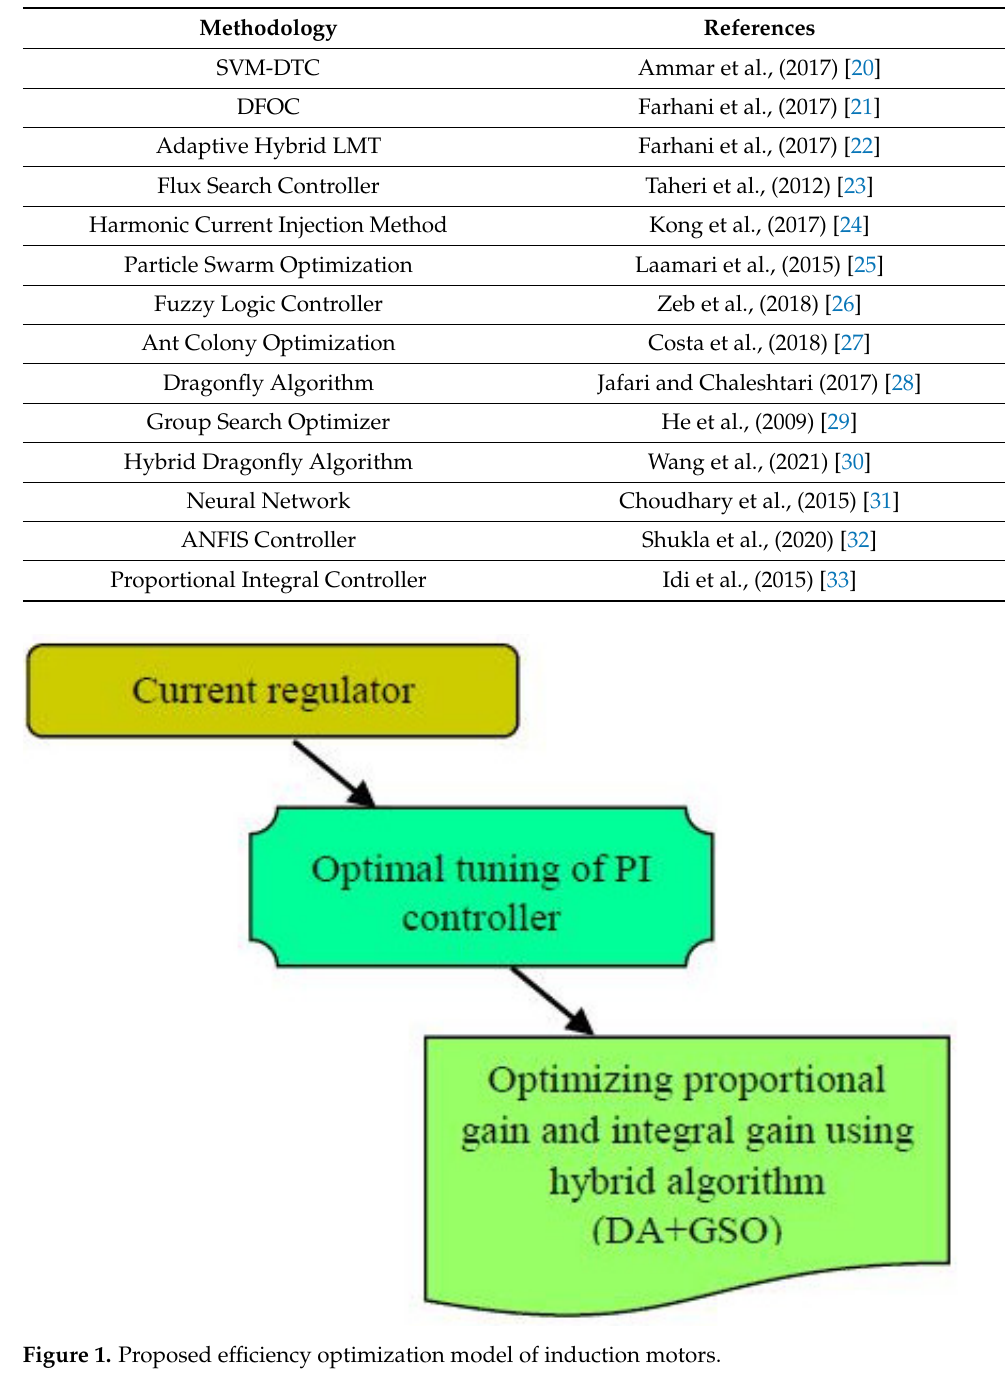
Table 1. Methodology used in traditional induction motor models.